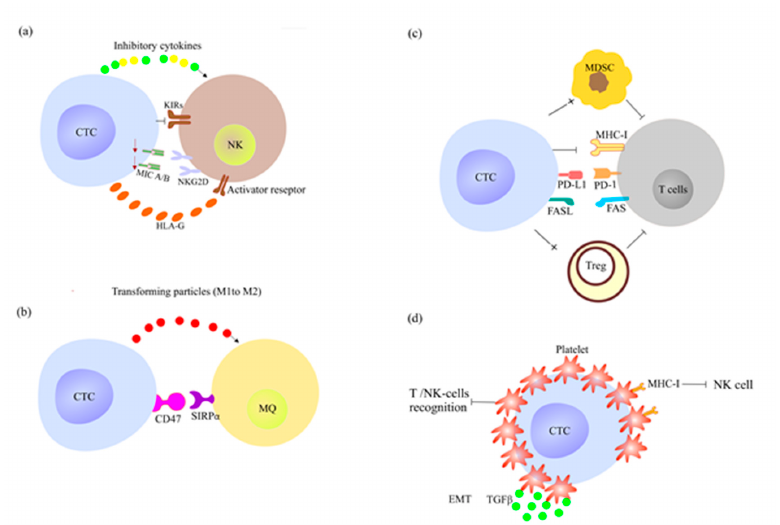
Figure 3. CTCs evade the immune systems in several ways (a-d). ( a ) CTCs modulate NK cell activity by producing inhibitory cytokines and blocking NK cell activator receptors (e.g., NKG2D and KIRs). ( b ) CTCs induce production of tumor-supporting M2 type of macrophages (MQ). M2 macrophages induce matrix-remodeling, neoangiogenesis, and exert an immune suppressive phenotype, which